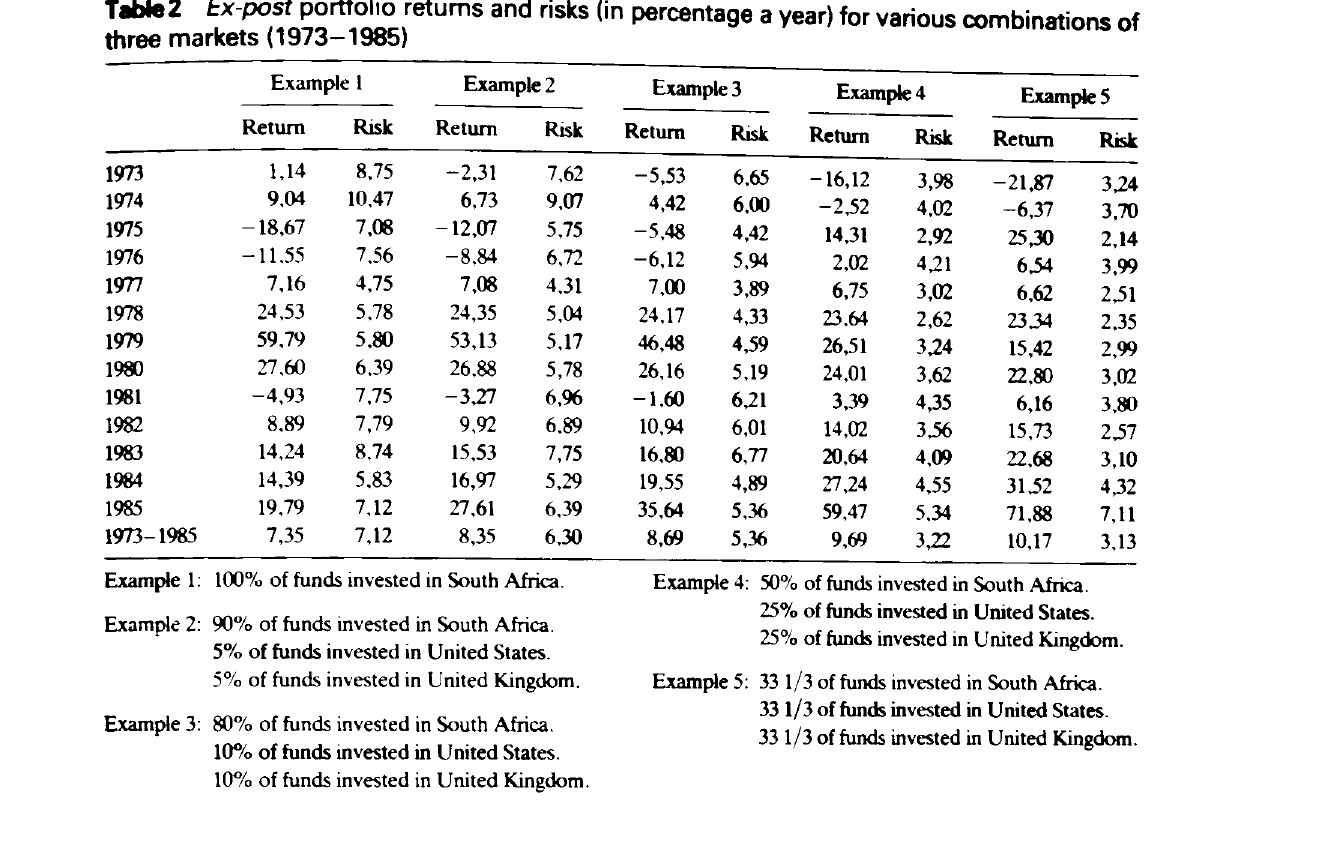
Table2 Ex-post portfolio returns and risks (in percentage a year) for various combinations of three markets